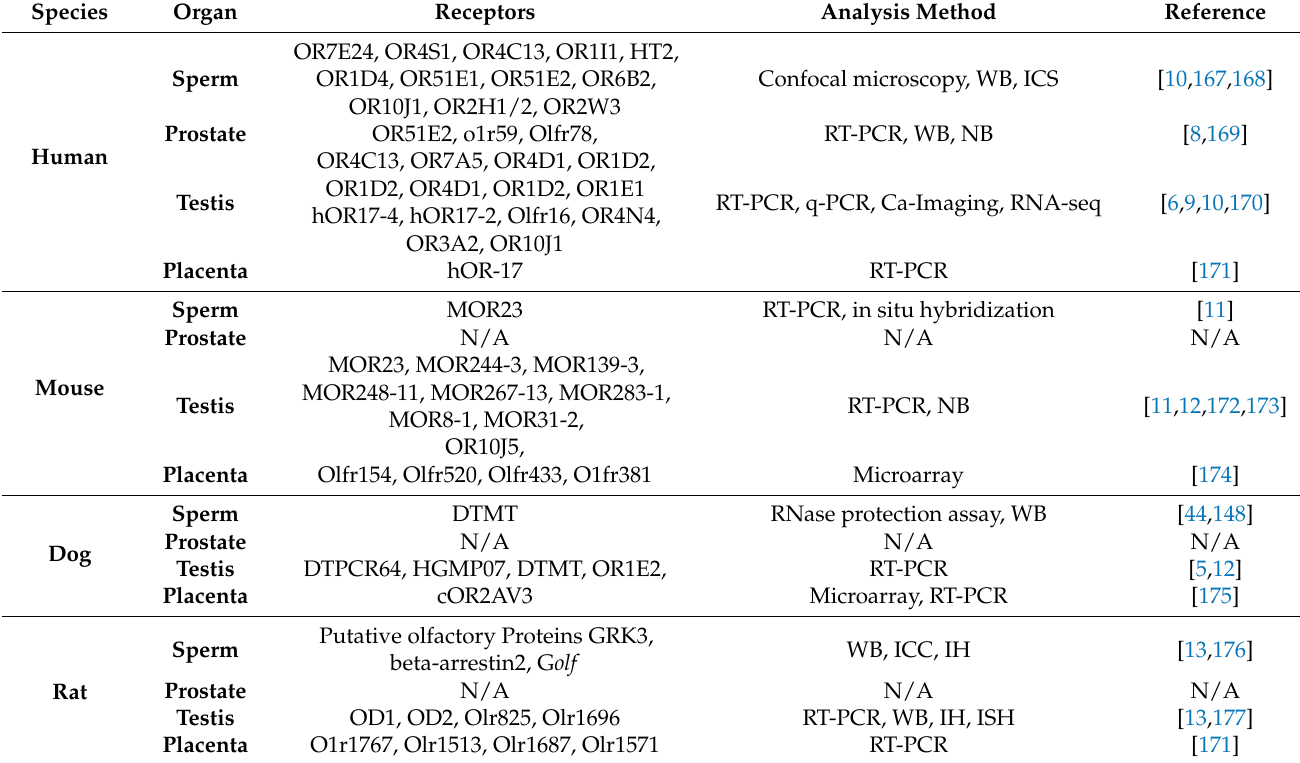
Table 3. Mammalian reproductive odorant